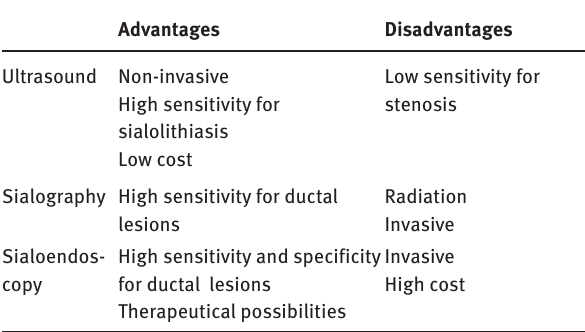
Table 2: Comparison of ultrasound, sialography, and sialoendos- copy in ductal pathology